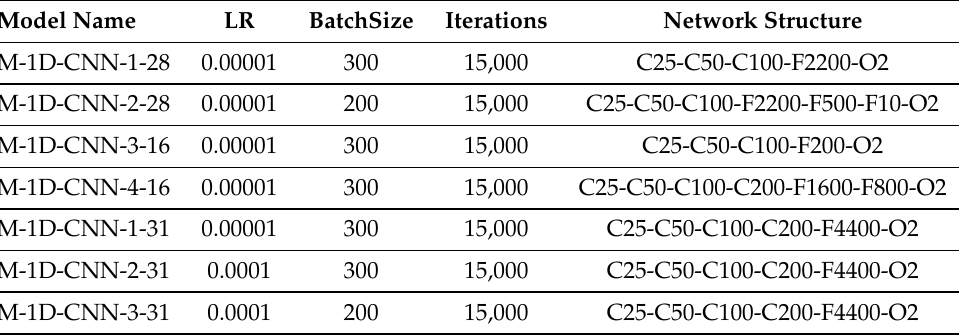
Table 2. Proposed networks structure. Here convolution, fully connected, and output layers are represented by C, F, and O. The number shows the number of kernels/neurons in that layer. Model Name LR BatchSize Iterations Network Structure M-1D-CNN-1-28 0.00001 300 15,000